Question: What form of chart is displayed?
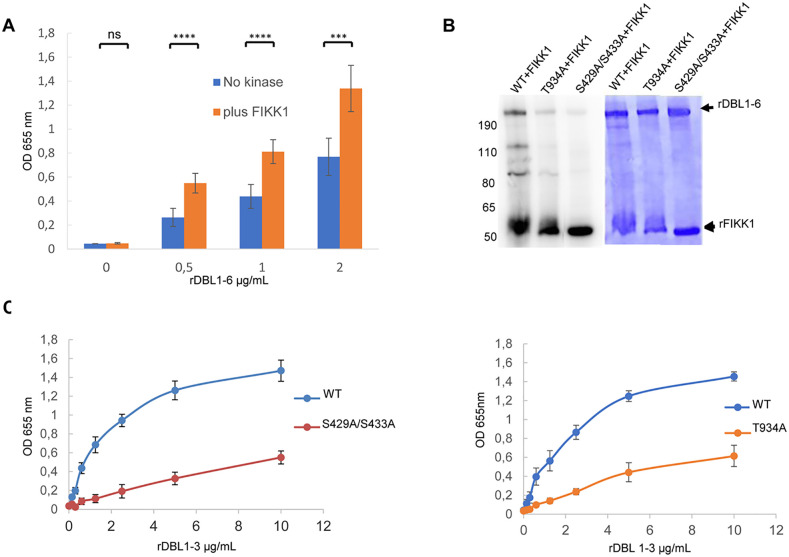
Answer: bar